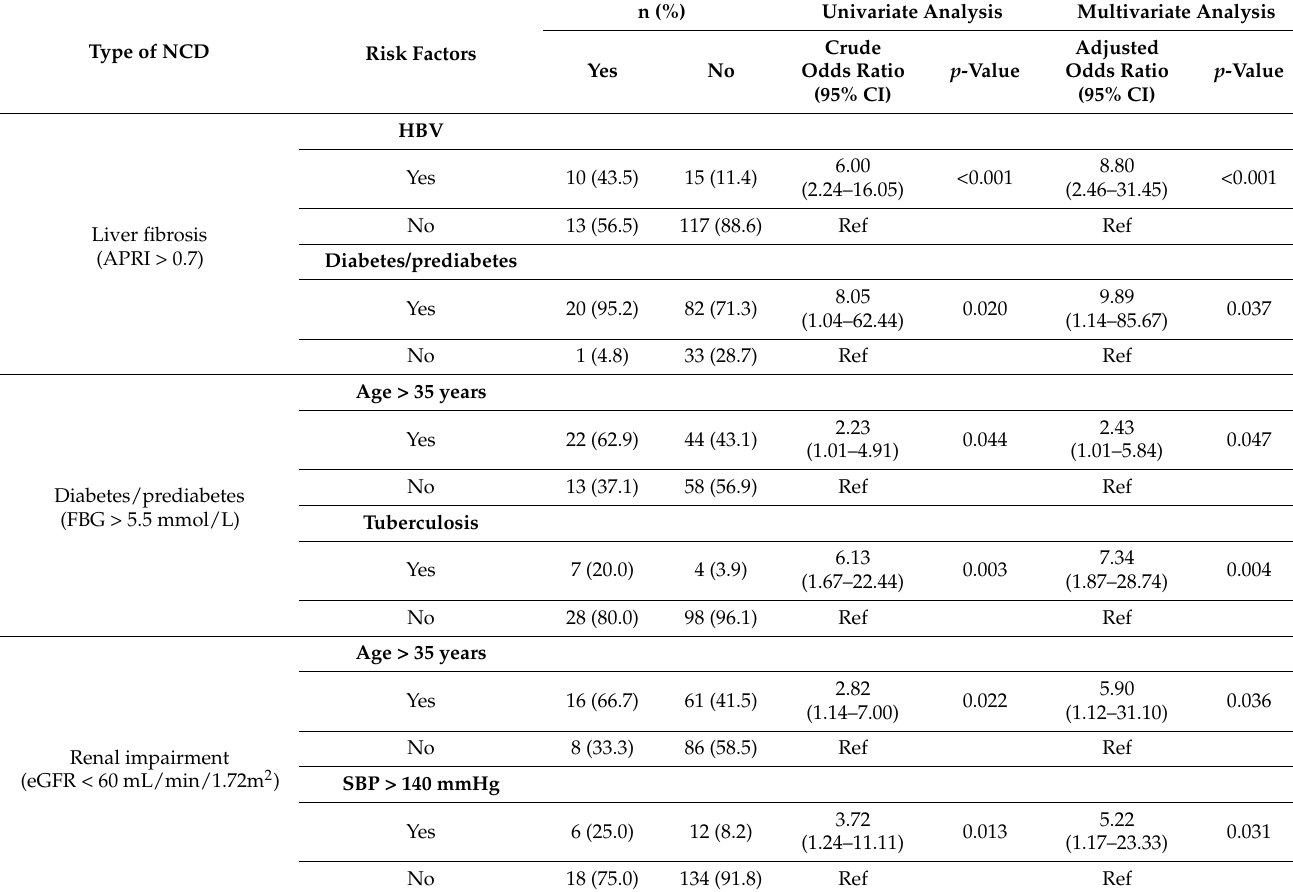
Table 4. Factors associated with